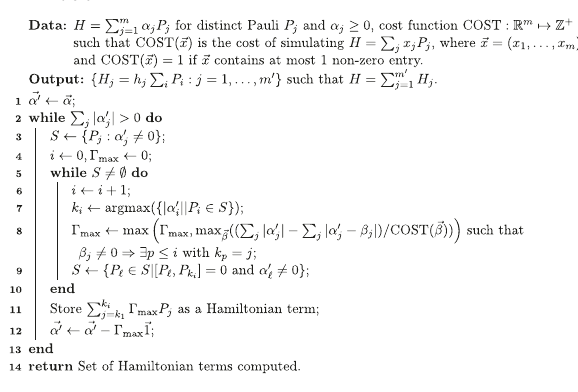
Algorithm 1 . Hamiltonian compilation using Greedy